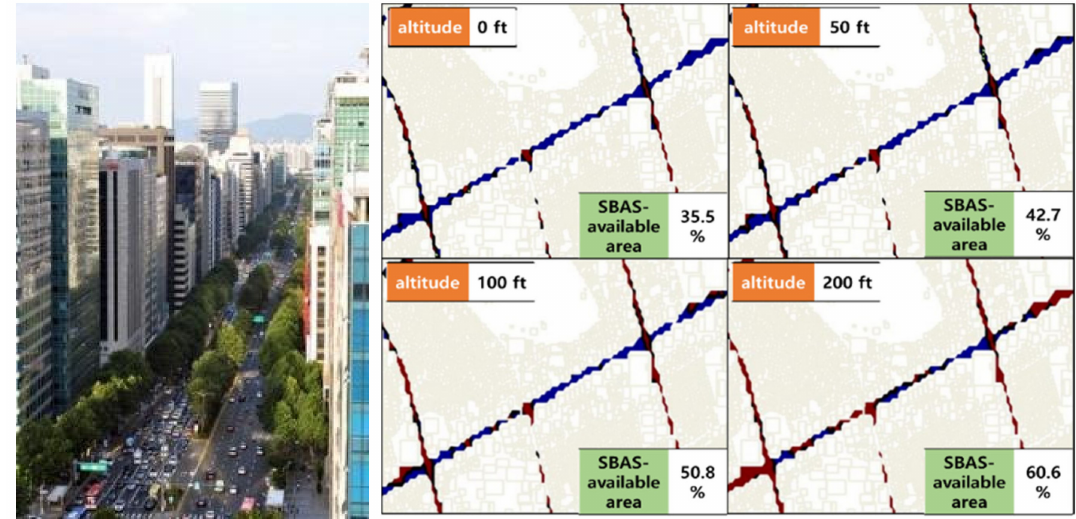
Figure 4. Urban canyon of Teheran-ro ( left ) and SBAS availability in Gangnam-gu, Seoul ( right